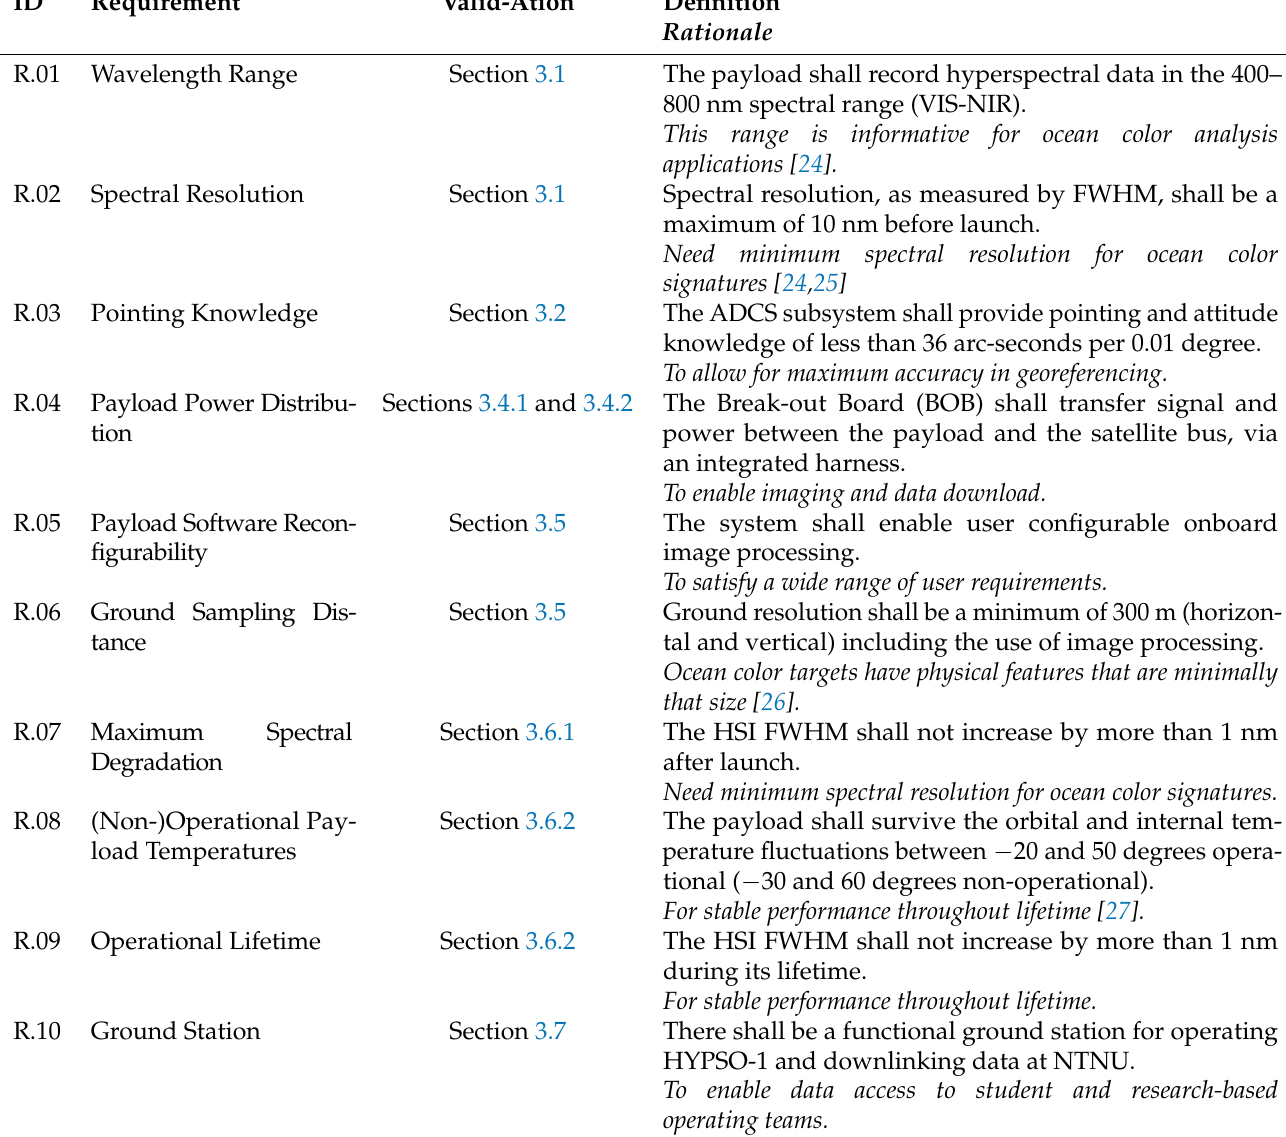
Table 2. Selected payload performance requirements from the HYPSO-1 mission; used to demonstrate validation in the AIT campaign. The Validation column points to the section in this paper that explains how each of these requirements were validated. Note: these are the high-level requirements; they are not quantified at the level they are presented at. Full-Width at Half-Maximum (FWHM) refers to the Full-Width at Half-Maximum of signal intensity peaks measured for calibration. Requirements derived from: previous missions [24,25], the IOCCG [26], and ESA’s tailored ECSS